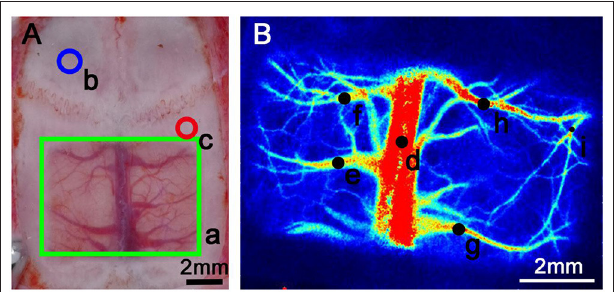
FIGURE 1 | Schematic diagram of transparent bone window preparation and LSCI monitoring of the rat skull. (A) a: The green rectangular area is the transparent bone window area, with dimensions of 7 × 5mm. The skull was polished until transparent, making the underlying blood vessels visible. b: The blue circle marks the area where the intracranial pressure probe was placed into a craniotomy. The center point was 1.5mm in front of the coronal suture and 1.5mm to the left of the sagittal suture, with a diameter of 2mm. c: The red circle marks the area where a craniotomy was created to allow injection into the subdural hematoma. The central point was 1.5mm behind the coronal suture and 3mm to the right of the sagittal suture, with a diameter of 1.3mm. (B) The black dots on the figure show the regions of interest (ROIs). d: Area of the superior sagittal sinus observation point. e–h: Collateral venous observation point. i: Arterial observation point. The areas above were selected for monitoring according to the specific experimental procedure because the hematoma formed by the injection would cover other blood vessels in the ipsilateral hemisphere; the actual measurement of the ipsilateral hemisphere was performed only on the selected blood vessels.